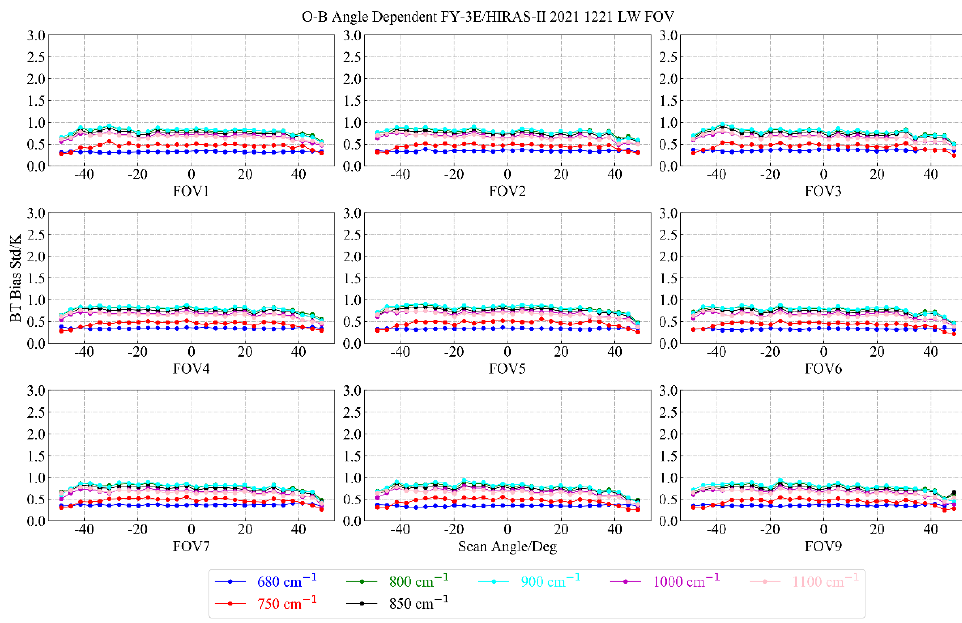
Figure 15. Distribution of OMB standard deviation of 9 FOVs of typical long-wave channels as a function of scanning angle.